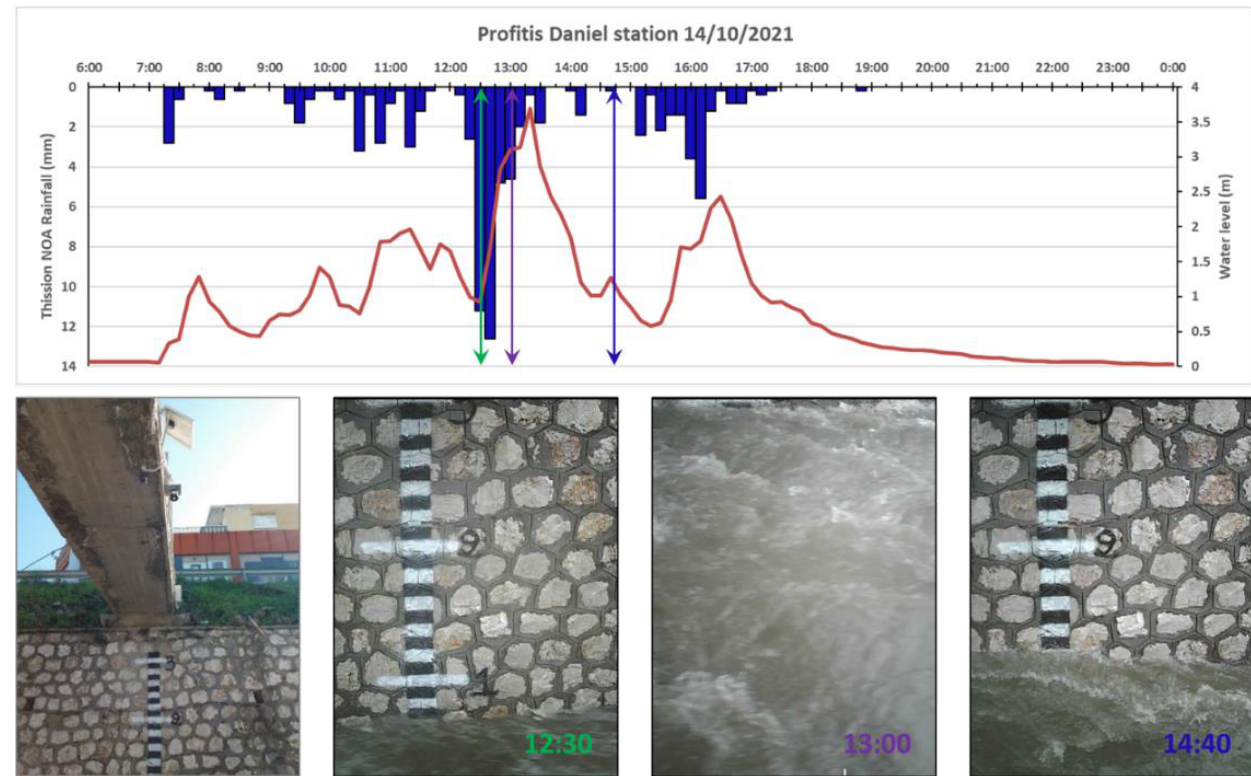
Figure 9. Profitis Daniel HTM station. Rainfall (blue bars) and hydrograph (red line) on 14 October 2021 ( upper part )—the arrows indicate the stage at the time of the photos in the lower part. ( Lower part ) shows a picture of the station ( left ) and consecutive photos captured automatically by the station’s camera, exhibiting the flow conditions in the stream. Rainfall data are from the automatic actinometric – meteorological station of IERSD/NOA at Thission.